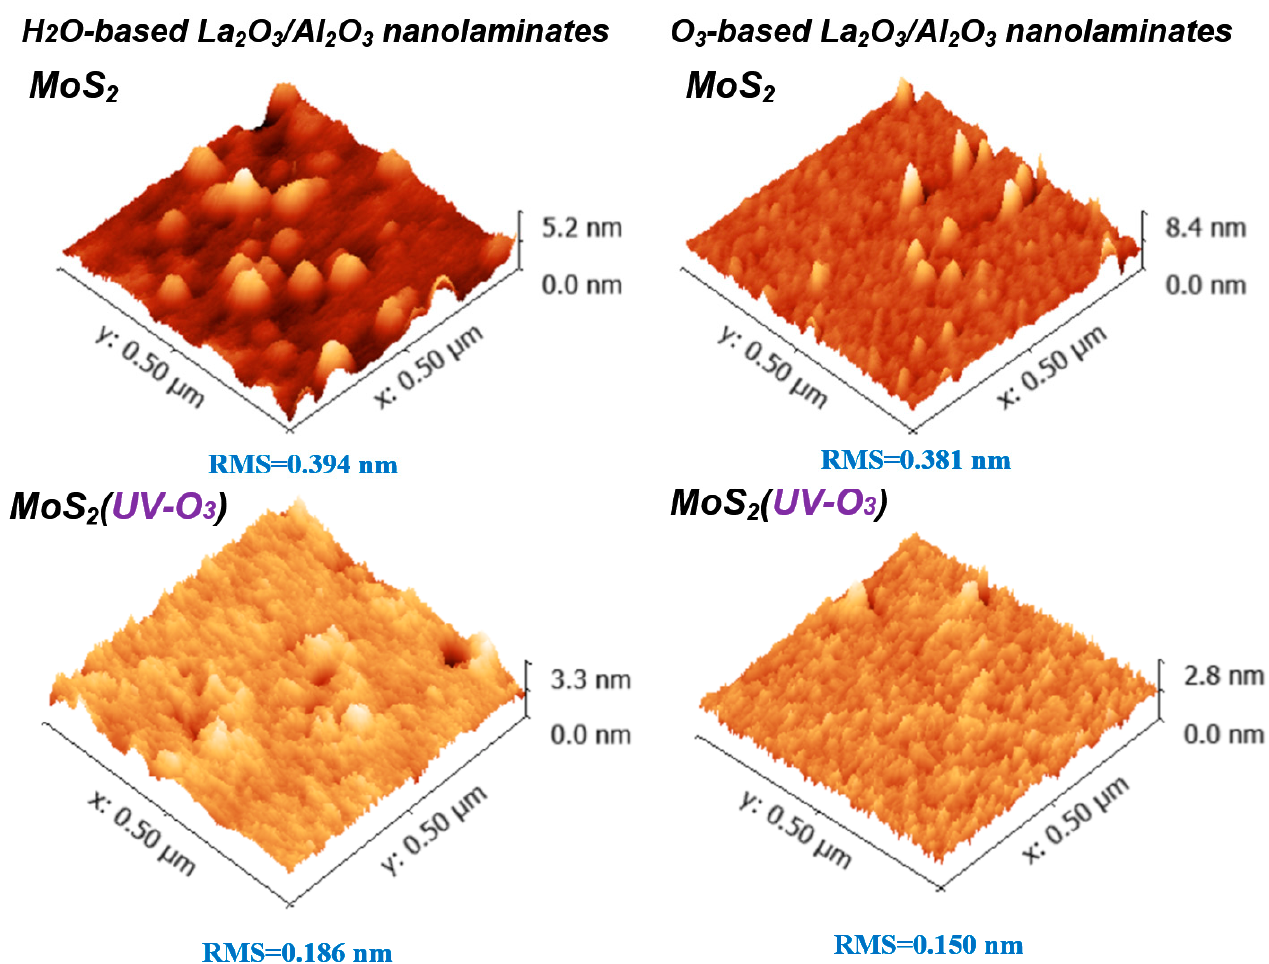
Figure 2. AFM results of sub-5 nm La 2 O 3 /Al 2 O 3 nanolaminates on MoS 2 with or without UV-O 3 treatment.